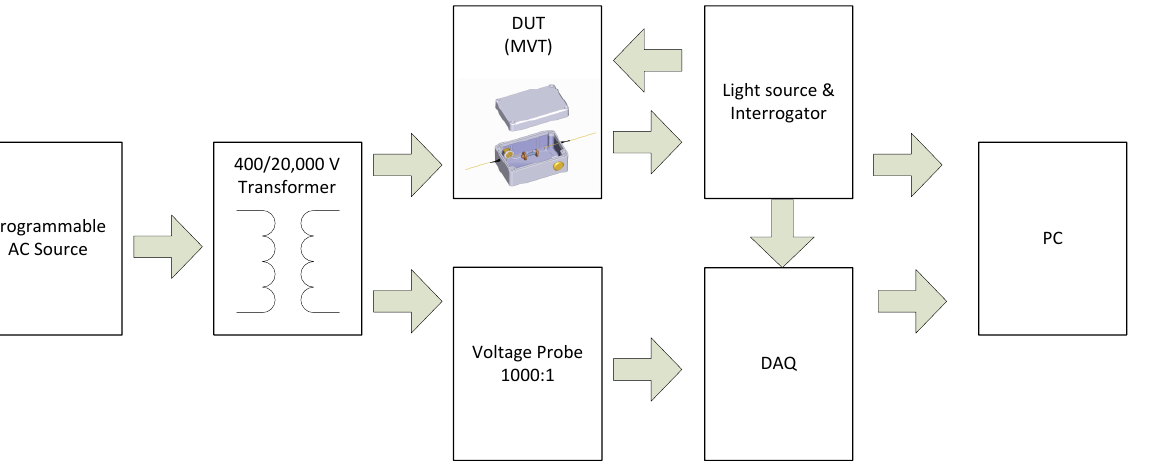
Figure 3. Experimental setup for MVT calibration and testing.